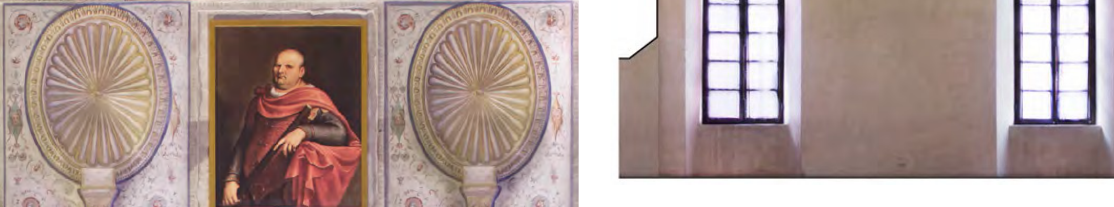
Figure 7. Details and sections of the room (by photos and by lines) coming from Photoscan